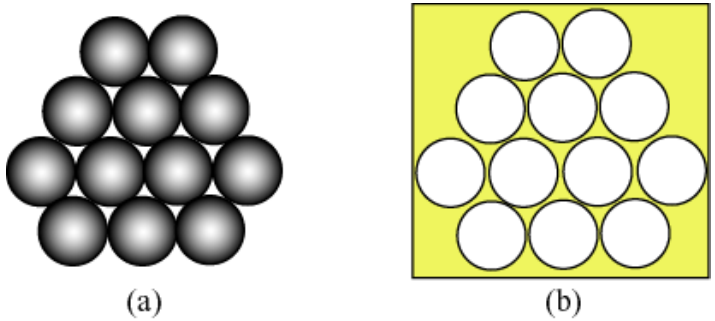
Figure 3. Two types of colloidal crystals, ( a ) opal and ( b ) inverse